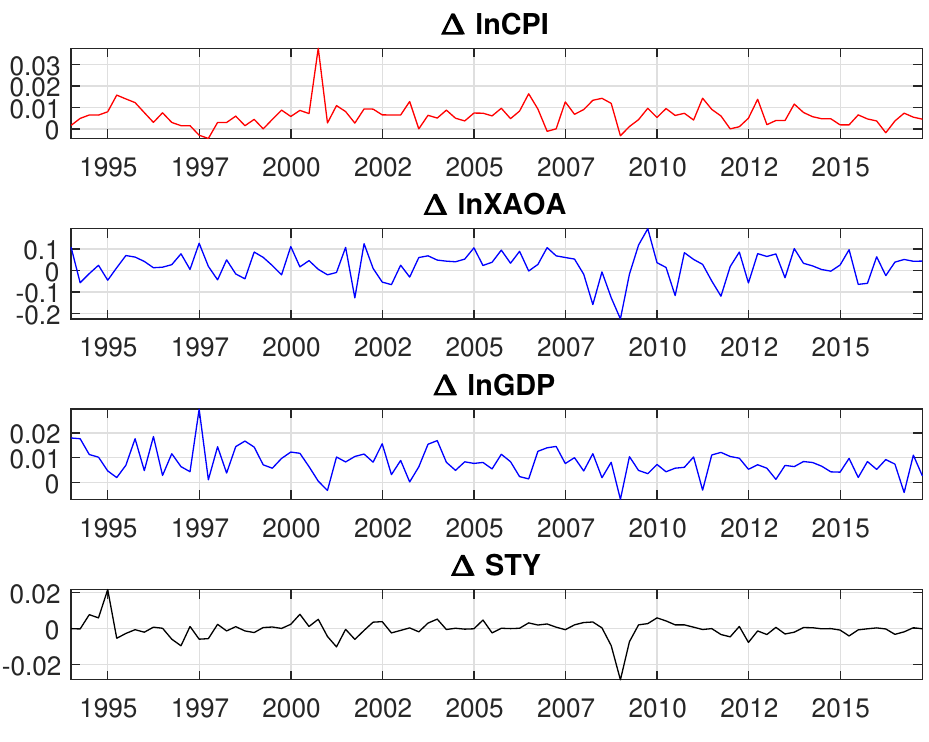
Figure A8. First difference of Log Scale